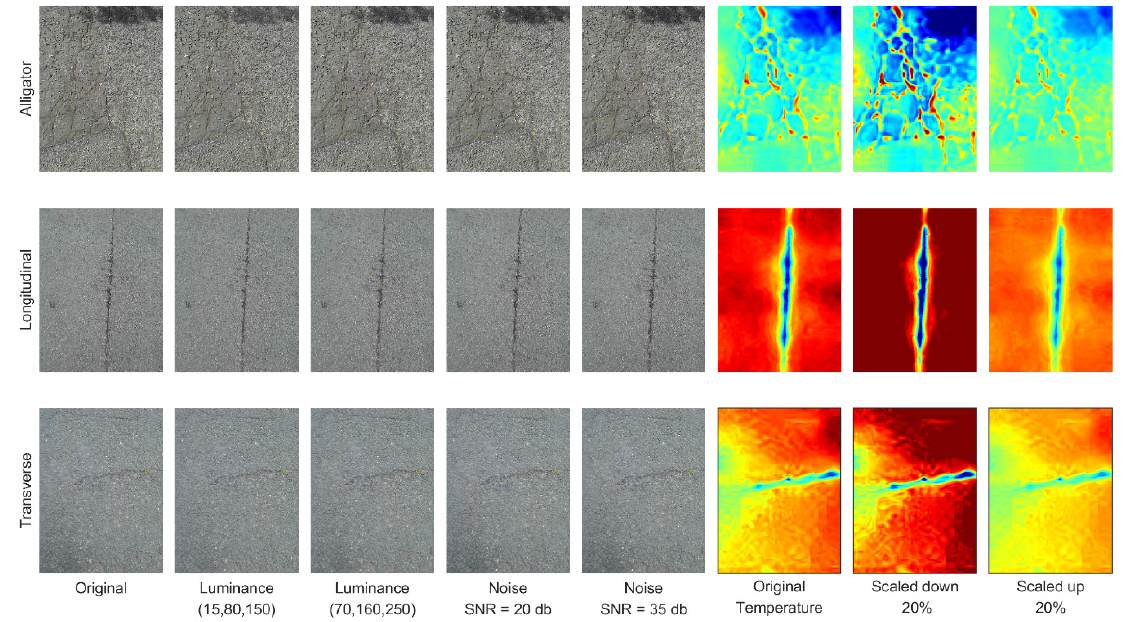
Figure 3. Data augmentation of alligator crack, longitudinal crack and transverse crack.